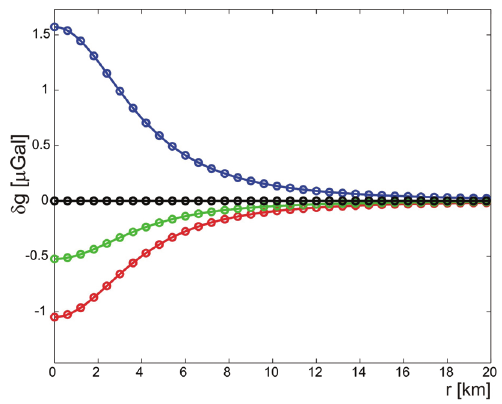
Fig. 1. Comparison between the analytical solu- tions (solid line) and the finite element results (cir- cles) for the δ g 1 (blue), δ g 2 ∆ V (red) and δ g 3 (green) for a spherical source. The overall gravity change vanishes identically (black circle) as demonstrated analytically (black solid line) by Walsh and Rice